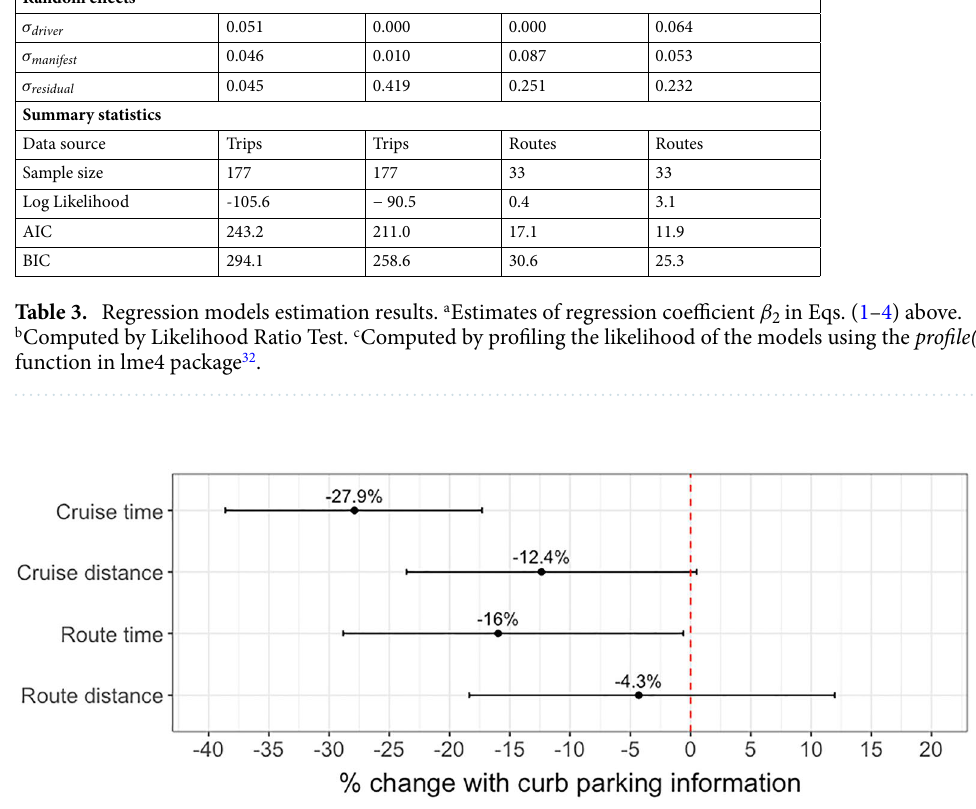
Figure 6. Estimated impact and 95 percent confidence interval of providing delivery drivers with curb availability information on the main variables of